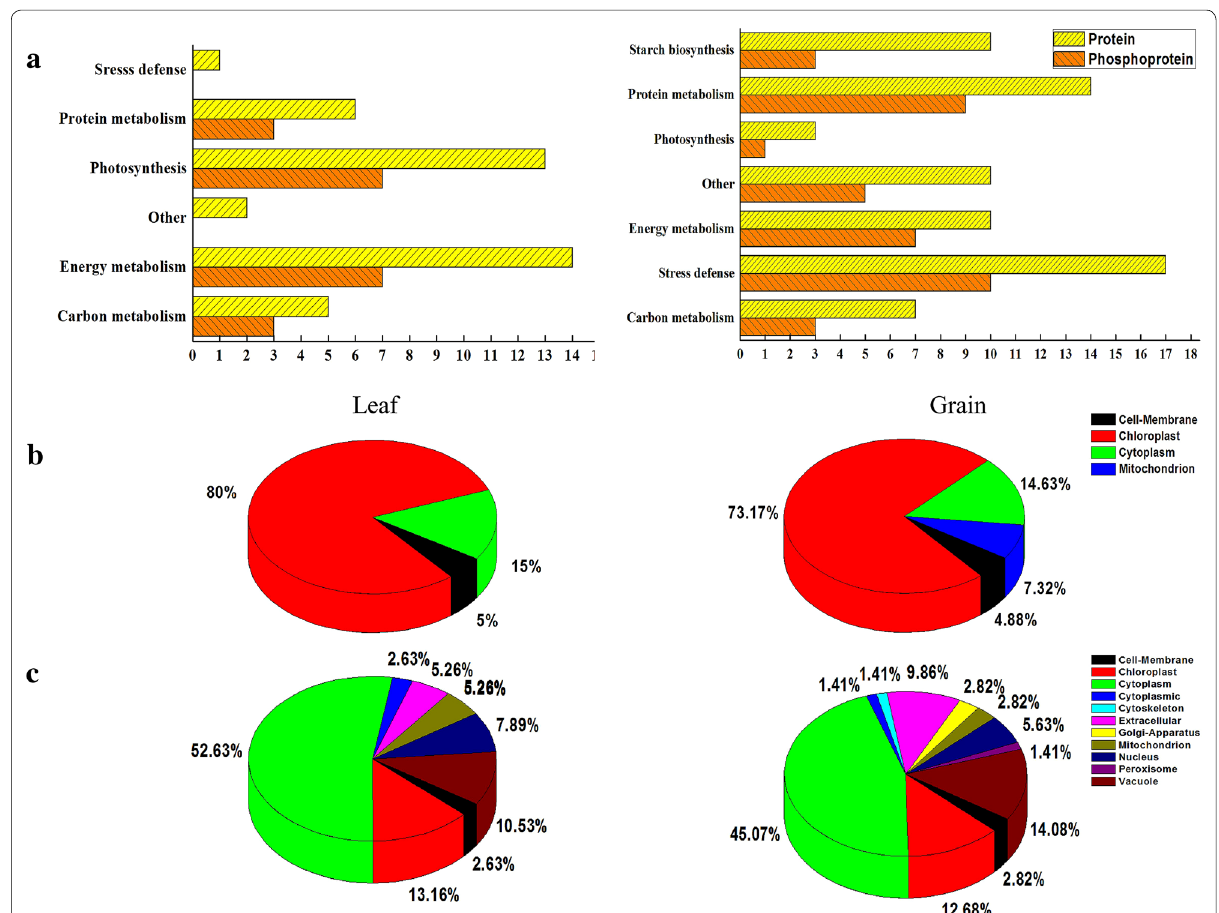
Fig. 4 Functional classification, subcellular localization and Venn diagram analysis of DAPs from flag leaves and developing grains in Zhongmai 175. a Functional classification of proteins in flag leaf and developing grain. b Subcellular localization of all proteins (right) and phosphoproteins (left) that we had identified in leaves. c Subcellular localization of all proteins (right) and phosphoproteins (left) that we had identified in developing